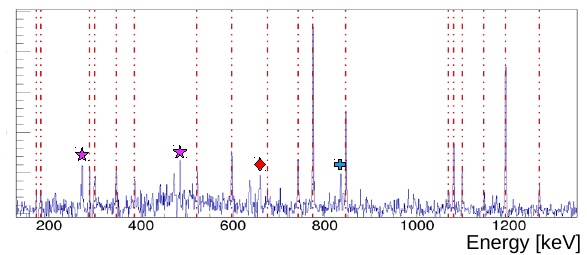
Figure 2. From γ -ray detected at 152 ◦ with a target-stopper dis- tance of 10 µ m, projection from a 2 p -coincidence γ - γ matrix on the 200-keV energy ground state transition of 105 Sn. The peaks corresponding to the main 105 Sn transitions are marked with ver- tical dashed lines. The peaks corresponding to the main contam- inants are also pointed out: (cid:31) 105 In, (cid:30) 102 Cd, (cid:29) 104